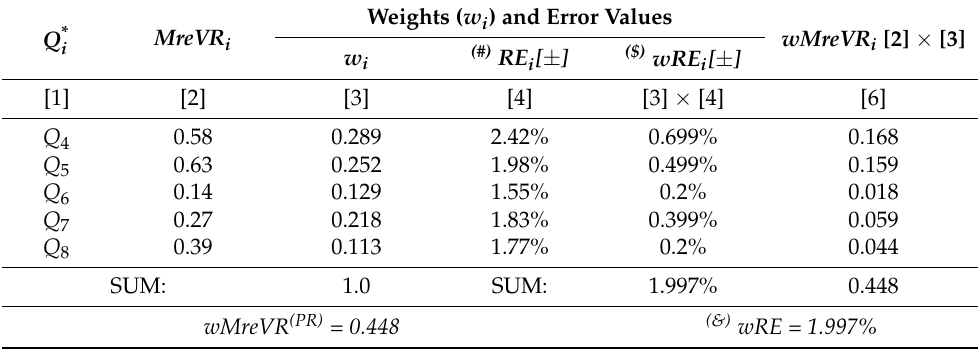
Table 14. Input for wMreVR (PR) calculation.